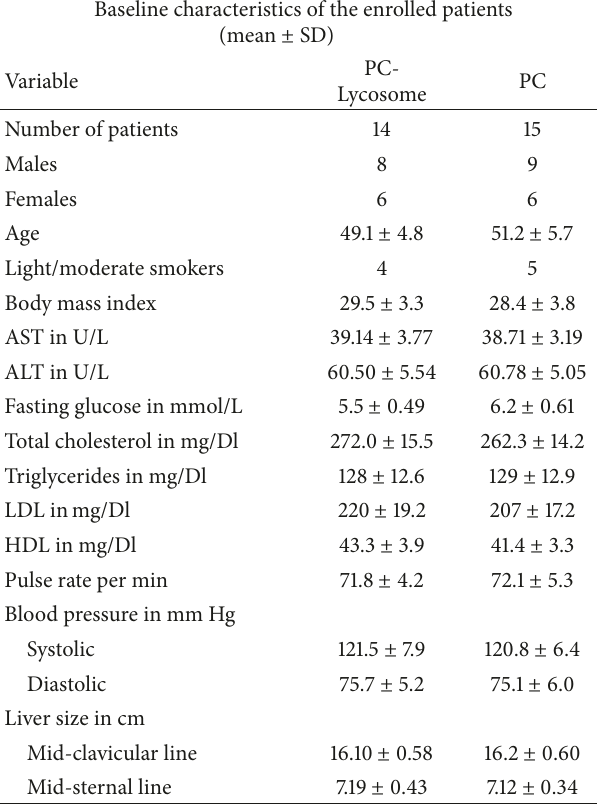
Table 1: Baseline